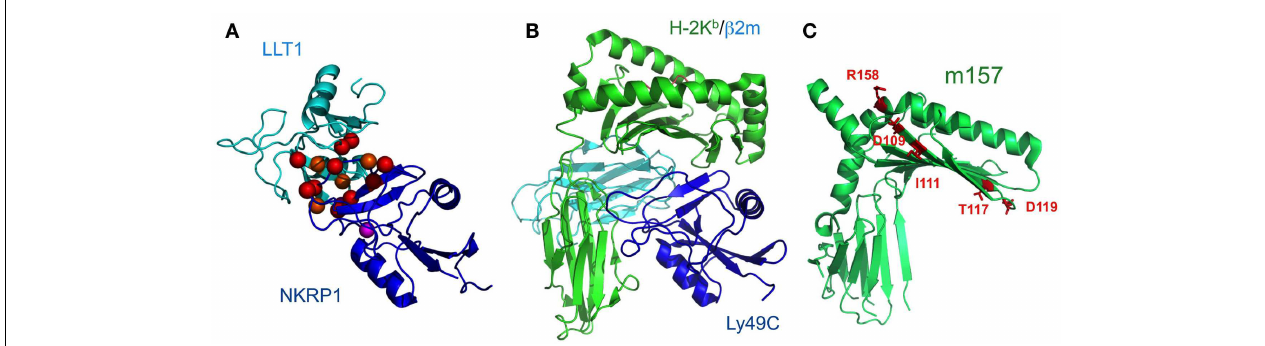
simultaneously (Kamishikiryo et al., 2011). (B) The crystal structure of Ly49C with H-2K b (H-2K b in green, β 2m in cyan, Ly49C in blue; PDB ID: 1P4L). Ly49C interacts with the β 2m subunit and the α 3 domain of H-2Kb, but not with the peptide-binding region.The crystal structure of m157 (PDB ID; 2NYK). (C) The mutation sites that identified the Ly49H binding residues are mapped and are shown in stick style (red).The residues did not overlap with the interface of the Ly49-MHCI complex